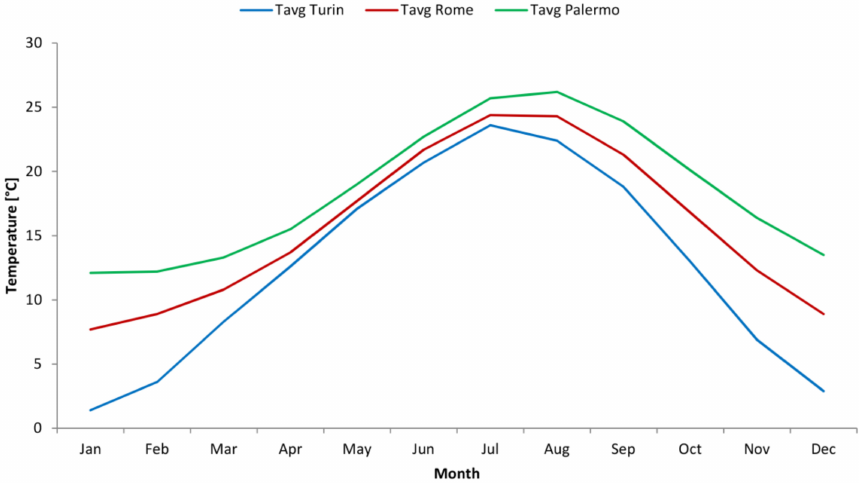
Figure 1. Average monthly temperature (Tavg) trends plotted for Turin, Rome, and